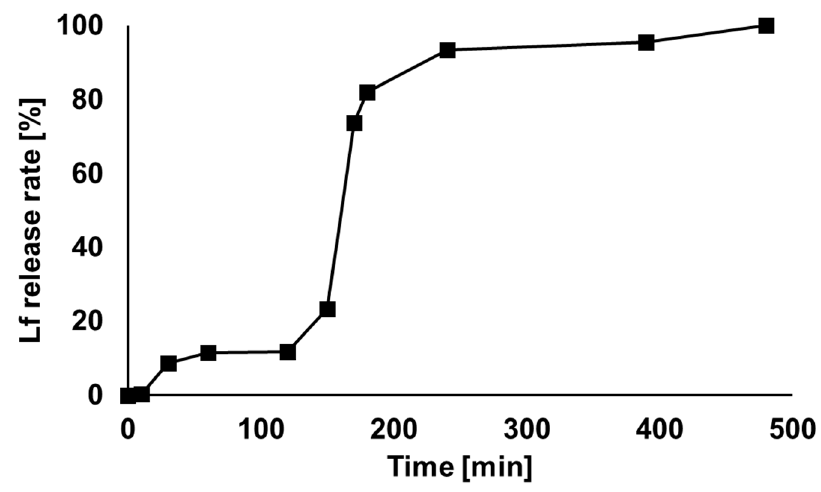
Figure 6. Sustained release profiles of Lf from shellac microcapsules produced by PGSS process of scCO 2 solutions at 40 °C and 10 MPa in simulated gastric fluid (SGF) (0–120 min in pH 1.2) followed by simulated intestinal fluid (SIF) (120–480 min in pH 7.4).